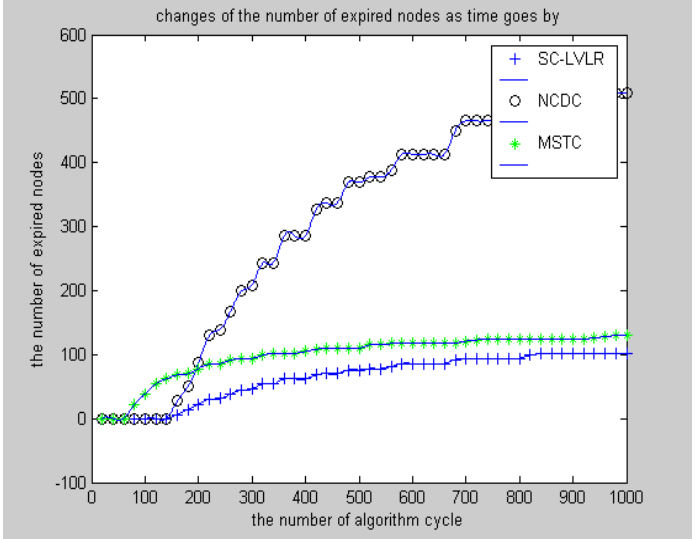
Figure 7. Changes of the number of expired nodes as time goes by.